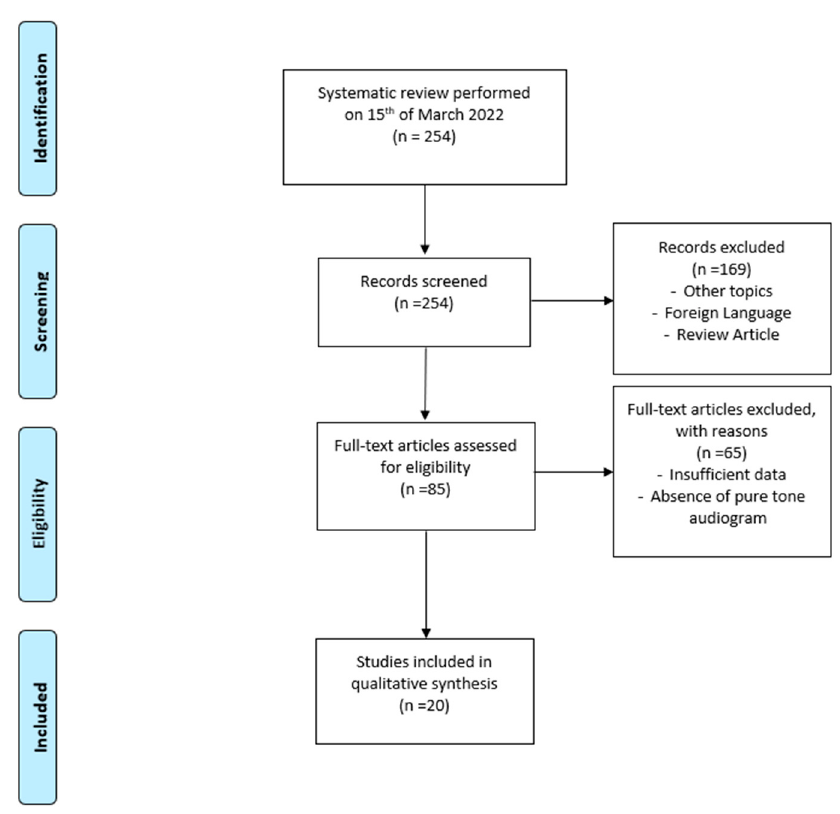
Figure 1. Literature evaluation and selection, according to PRISMA criteria (http://www.prisma- statement.org/ (accessed on 1 April 2022).